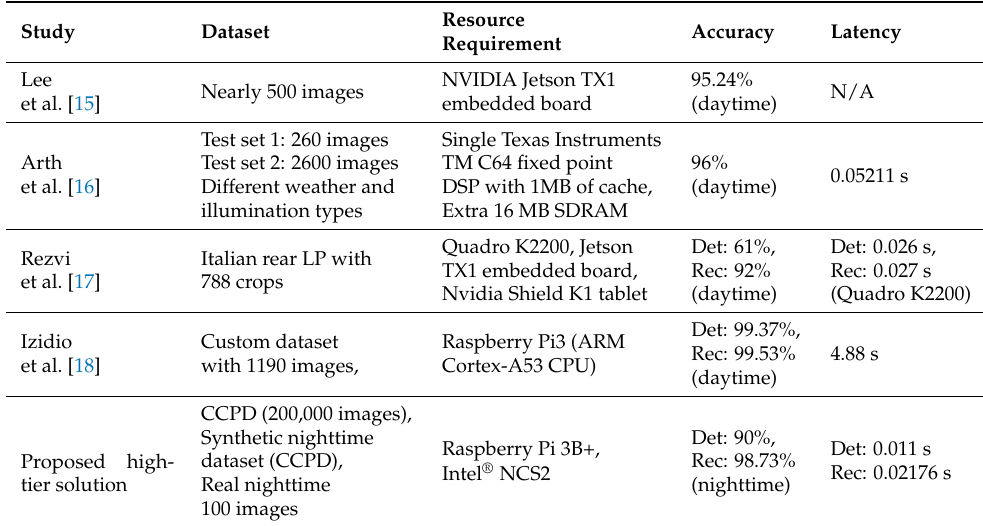
Table 9. Comparison with the related